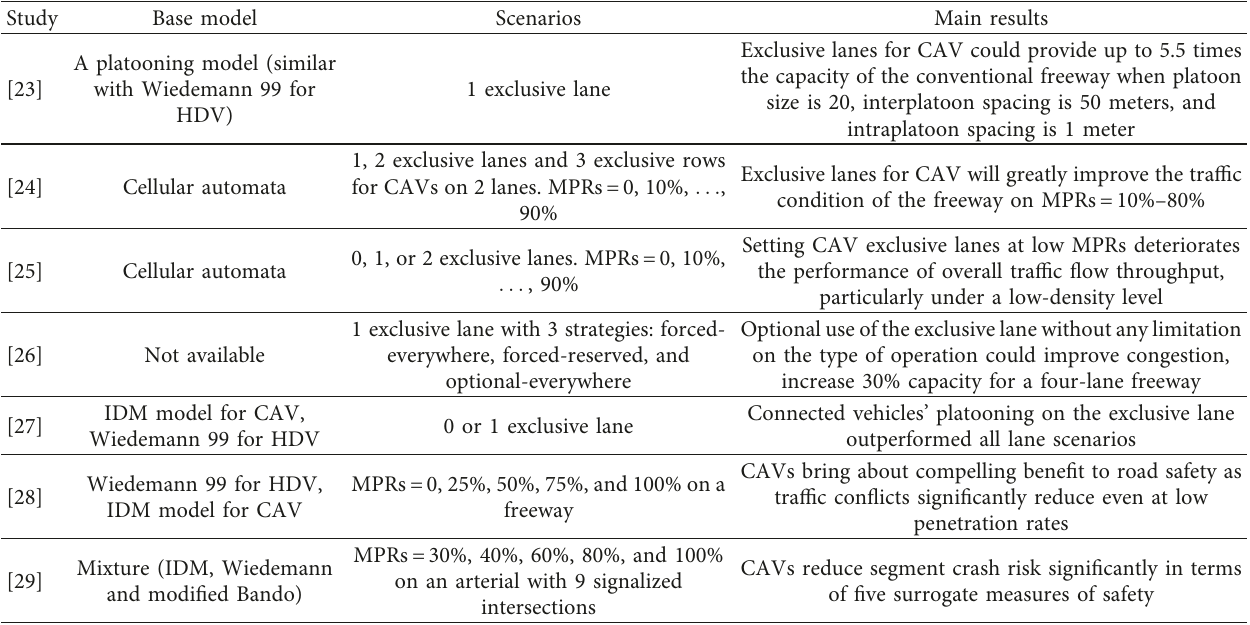
Table 1: Summary of previous research studies for connected and autonomous vehicles with mixture environment.